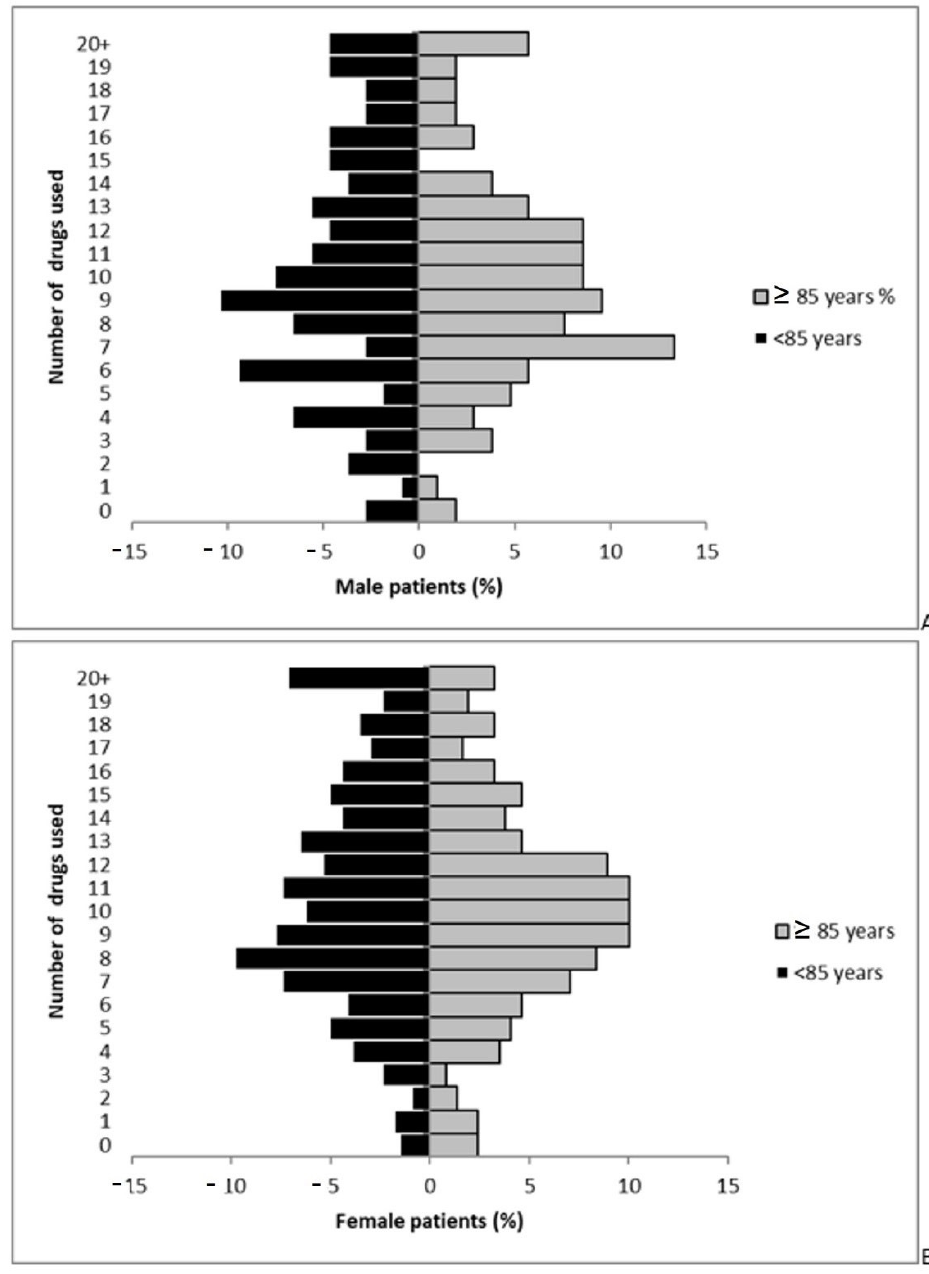
Figure 3. Pyramid charts of: ( A ) drug use in male patients by age; ( B ) drug use in female patients by age. Table 3. Results from multivariable logistic model for polytherapy. OR = odds ratio; LOS = length of stay in